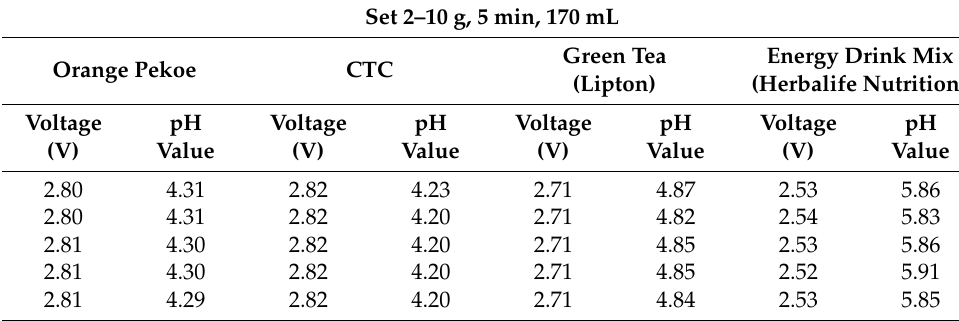
Table 5. pH value and the corresponding port voltage for Set 2–10 g, 5 min, 170 mL.